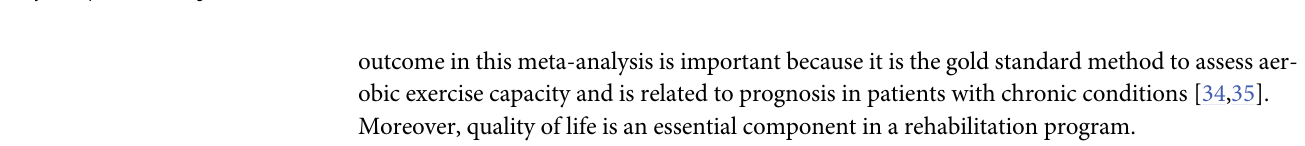
Fig 3. Combined aerobic and resistance exercise (CARE) versus No Exercise: Muscle Strength. Review Manager (RevMan). Version 5.2 The Cochrane Collaboration, 2013.